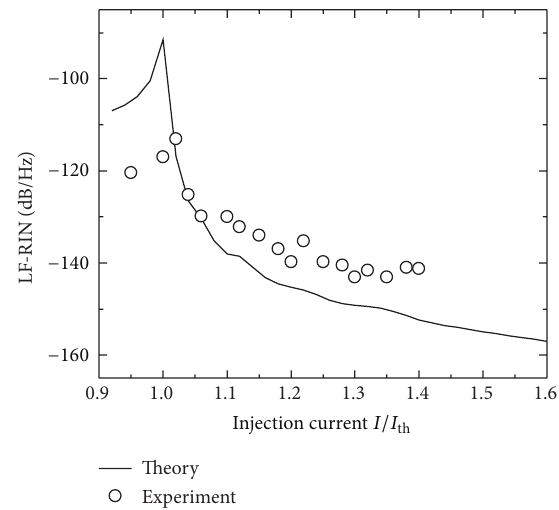
Figure 2: Variation of LF-RIN with the injection current 𝐼/𝐼 InGaN lasers (solid). The experimental results in [11] are shown (circles) for